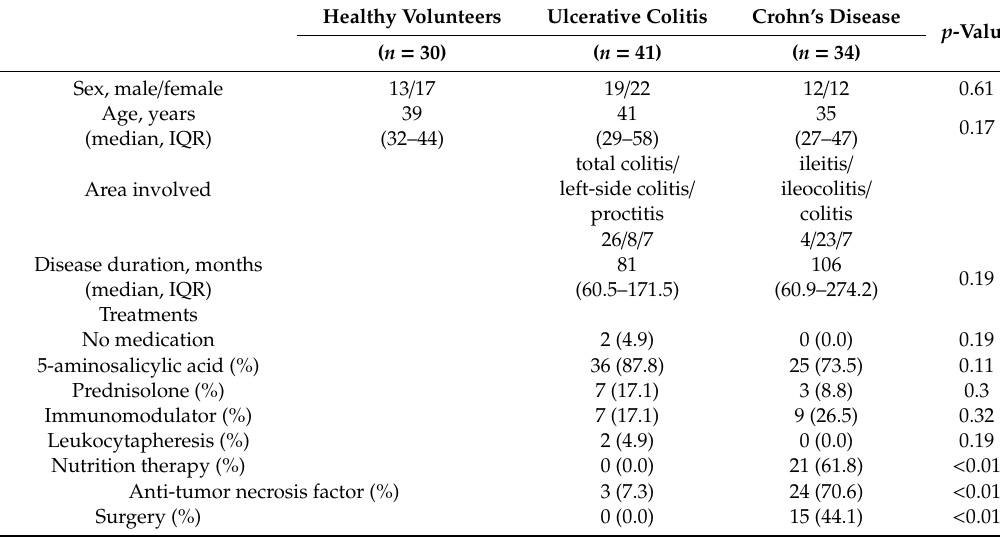
Table 1. Patient